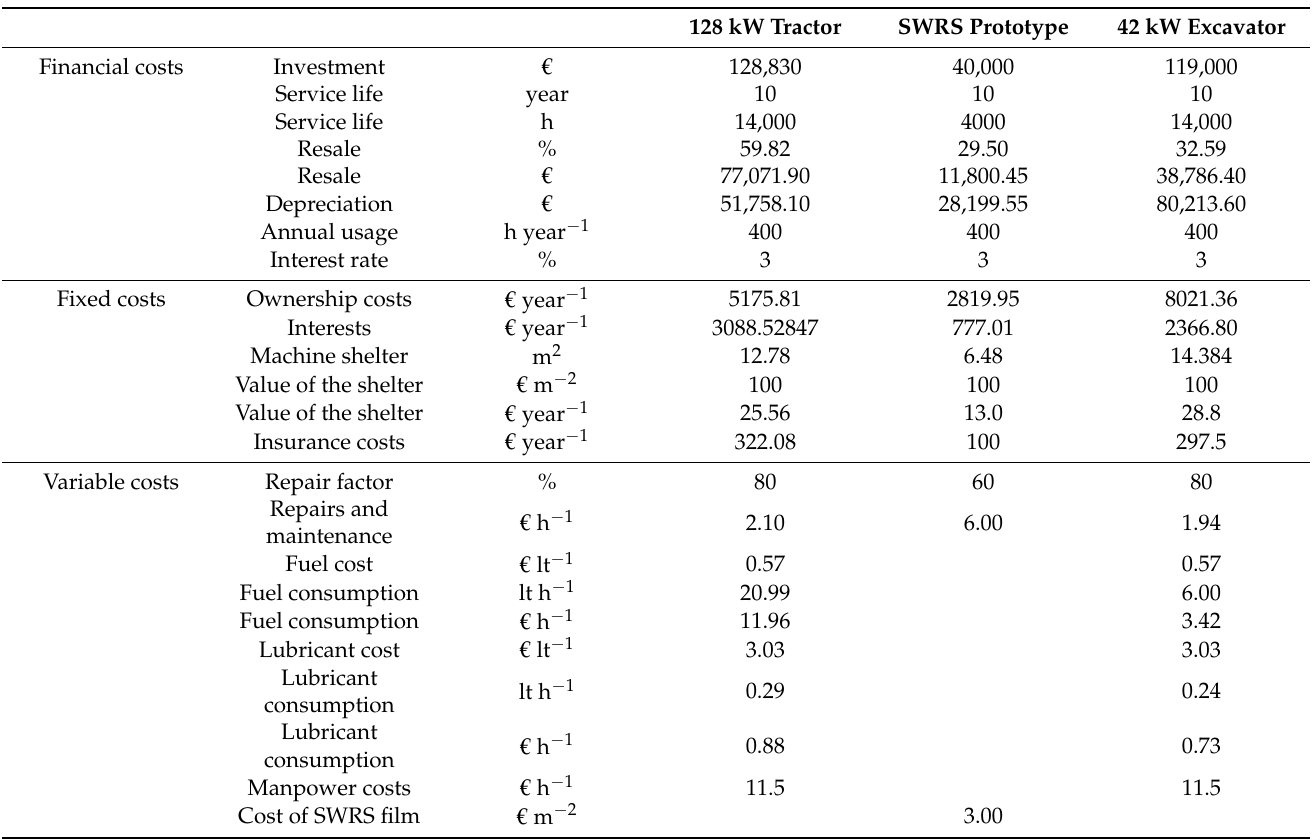
Table 4. Financial, fixed and variable costs evaluated.